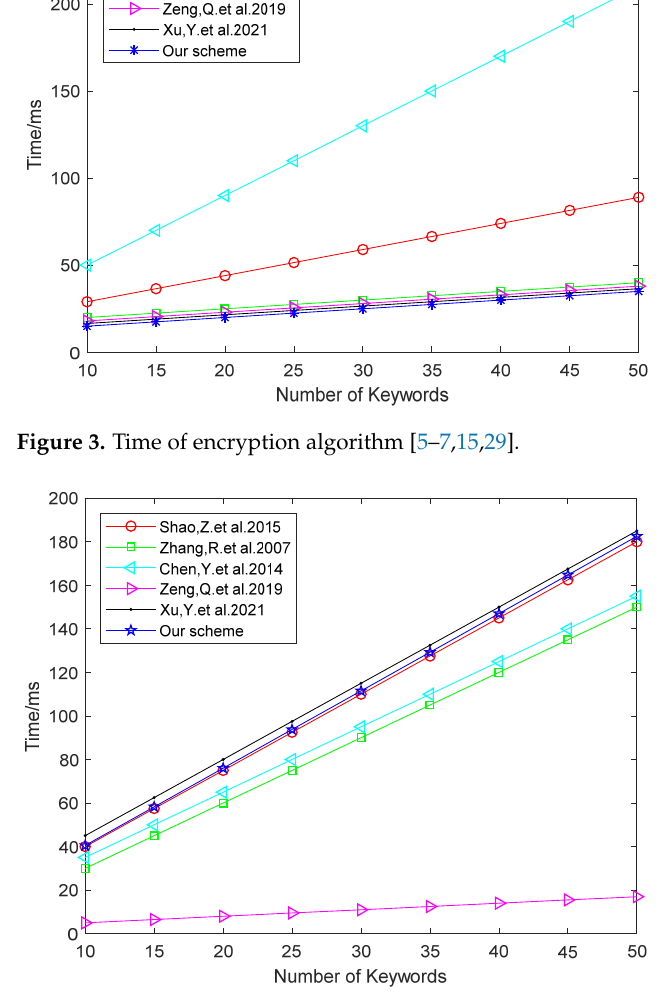
Figure 4. Time of test algorithm.